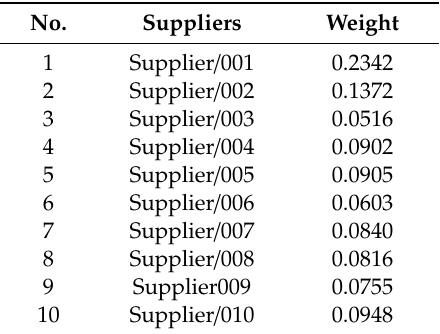
Table 7. Weight of all DMUs.